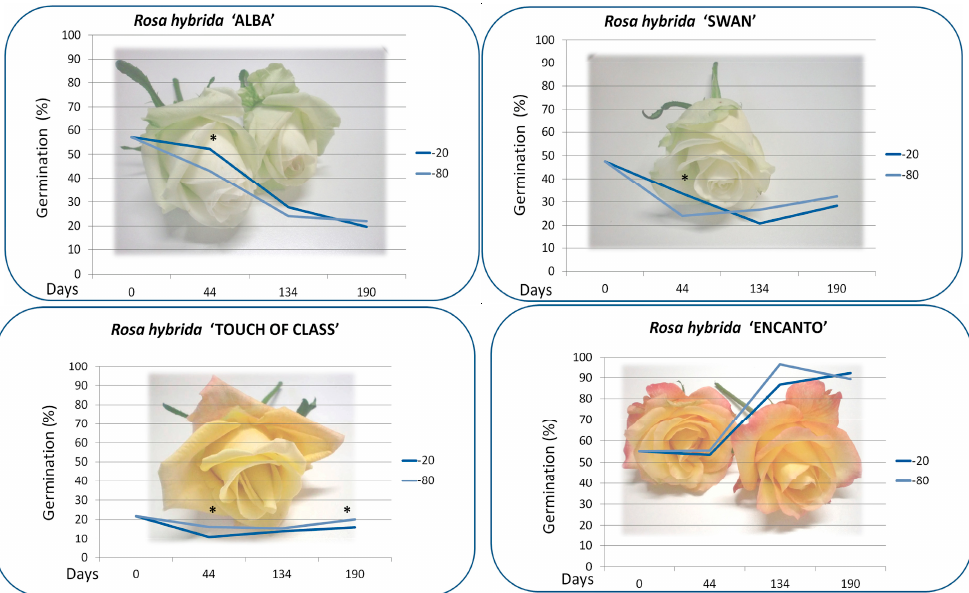
Figure 5 . “Alba”, “Swan”, “Touch of Class” and, “Encanto” rose pollen germination percentages at Day 0 (fresh pollen) and after 44, 134 and 190 days of storage at − 20 °C and − 80 °C. For each experimental point the asterisk indicates significant differences by one-way ANOVA at 5% probability. Reproduced from Giovannini et al. (2015) [6] with permission of ISHS. The germination percentage of the untreated pollen control stored at room temperature was reduced to zero within 10 days (data not shown).